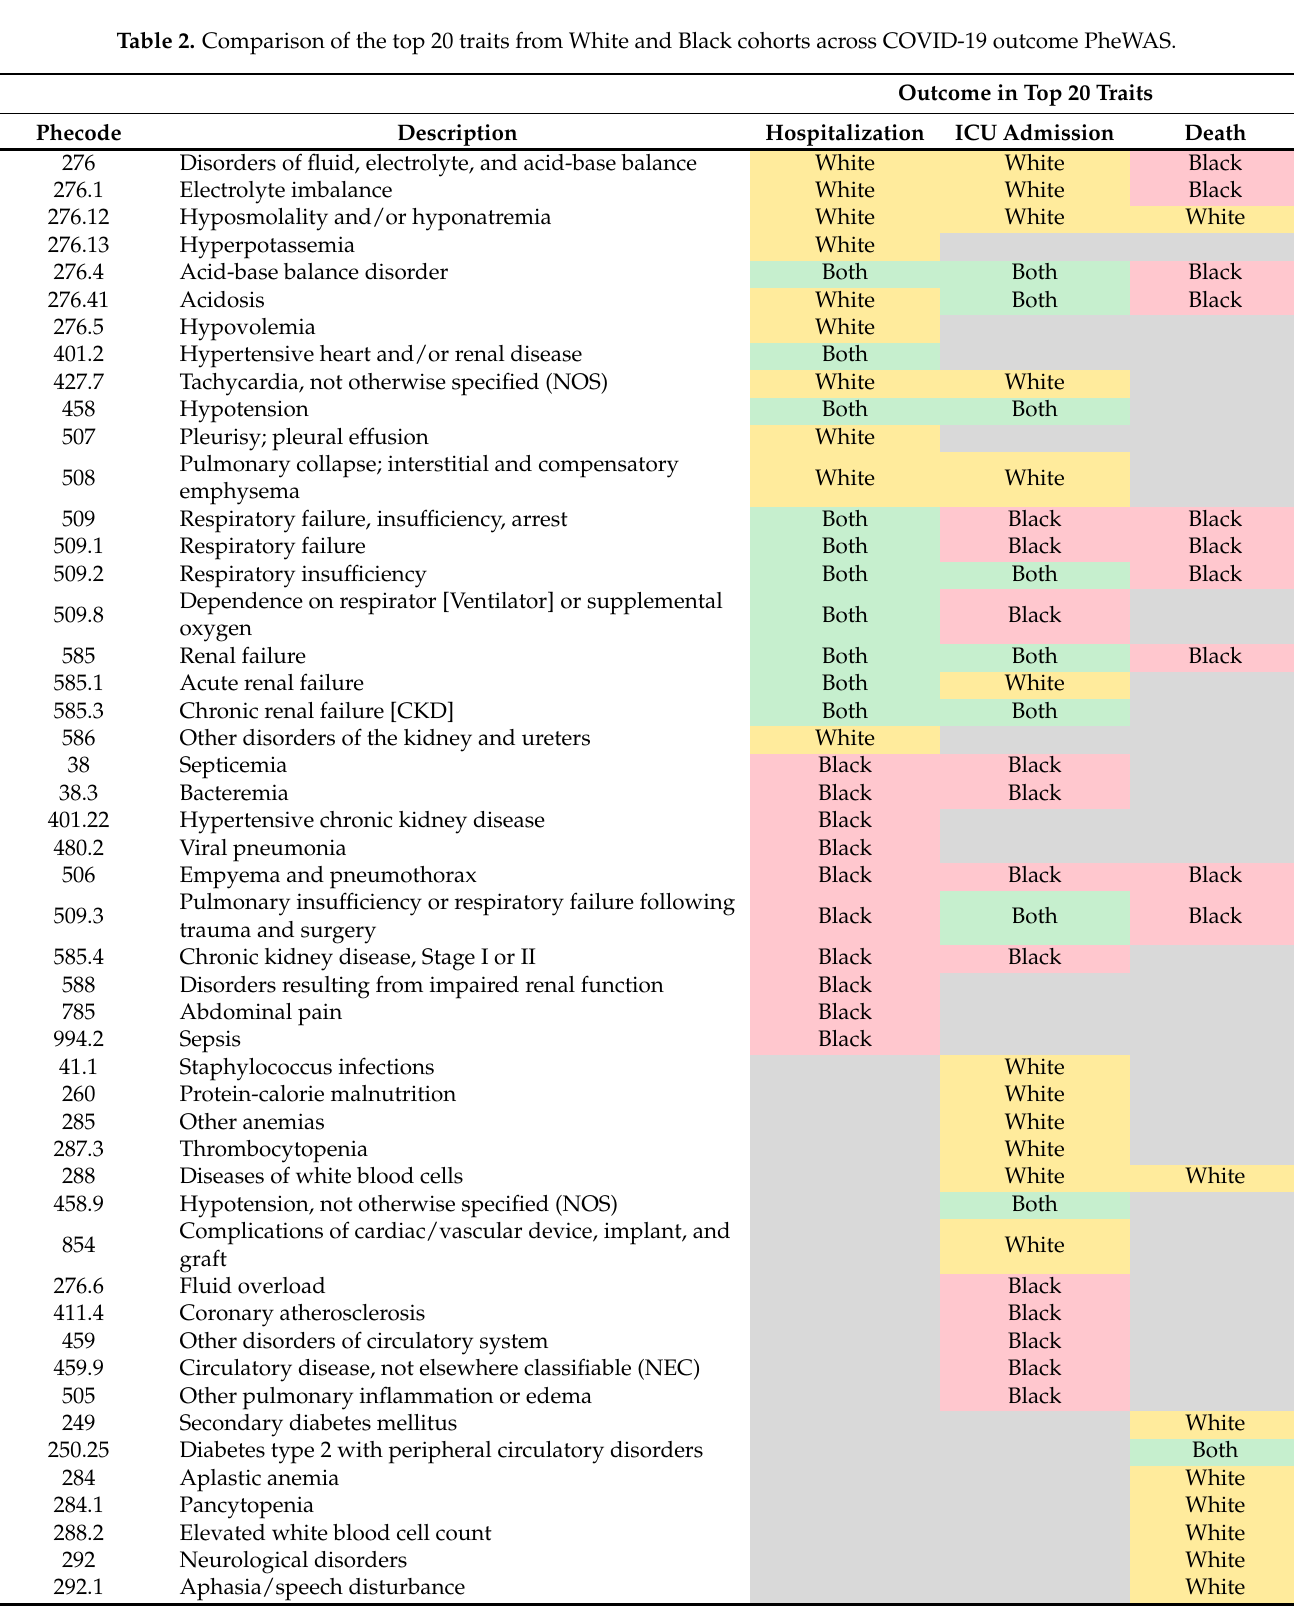
Table 2. Comparison of the top 20 traits from White and Black cohorts across COVID-19 outcome PheWAS.